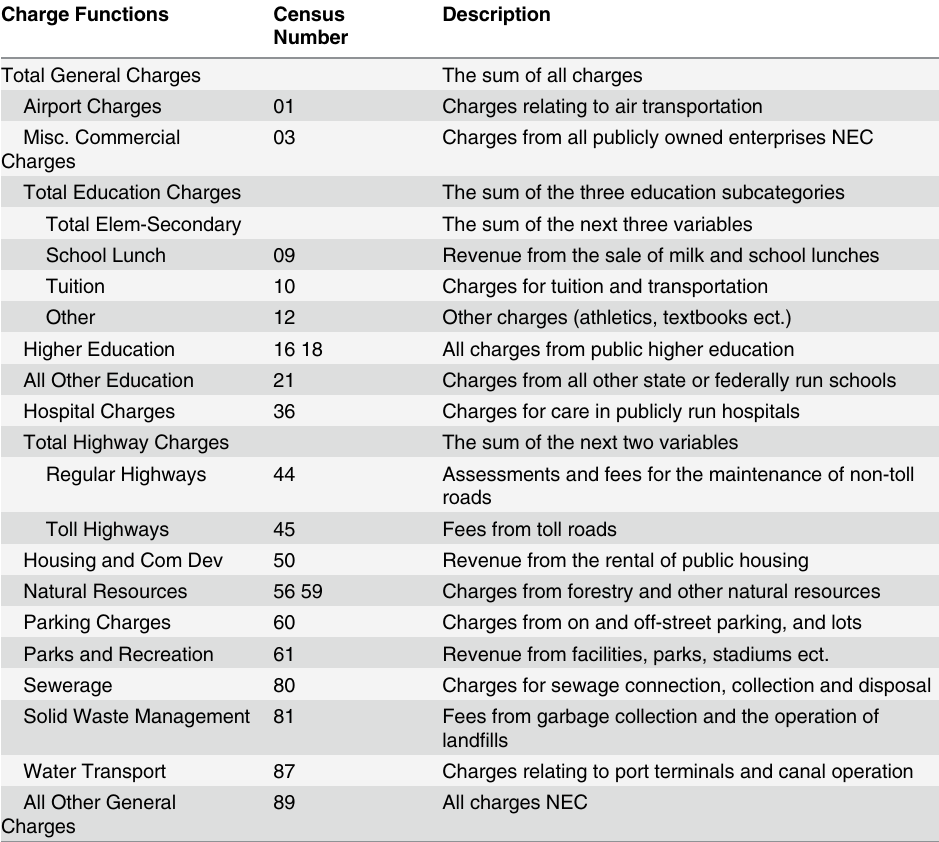
Table 4. Current Charge